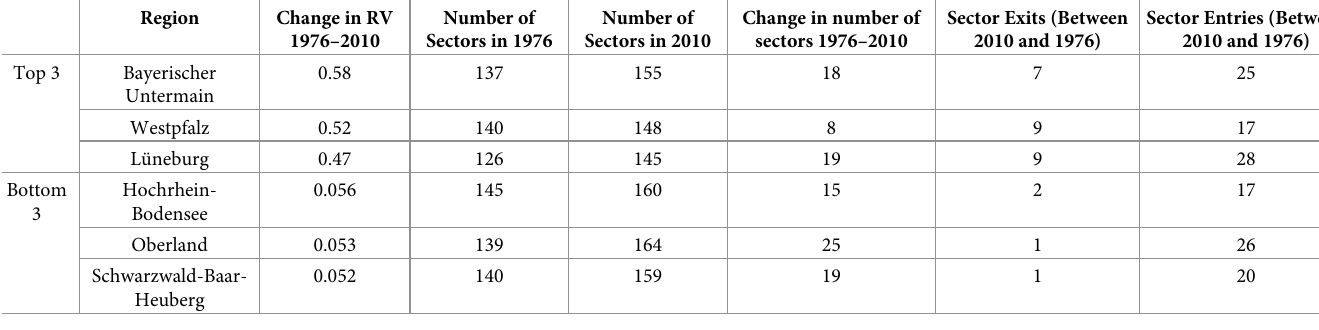
Table 2. Entries and exits of industries in Top 3 and bottom 3 regions in terms of RV.